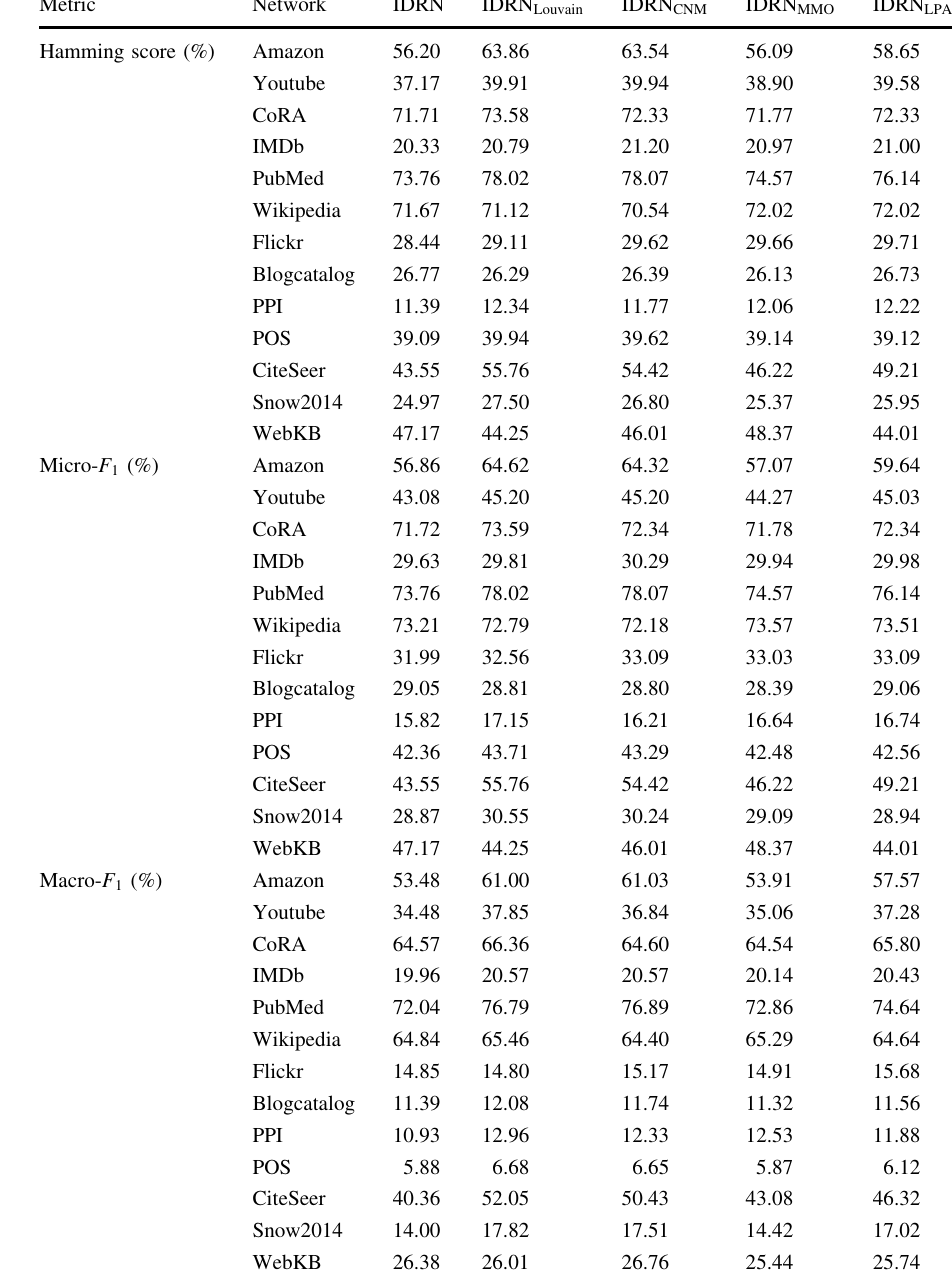
Table 3 Experiment comparisons of IDRN with different community prior by the metrics of Hamming score, Micro (cid:4) F 1 score and Macro (cid:4) F 1 score with 10% nodes labeled for